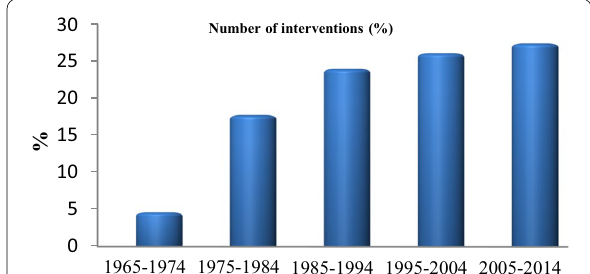
Fig. 2 Evolution of the number of operative interventions for urolithiasis between 1965 and 2014 by decade